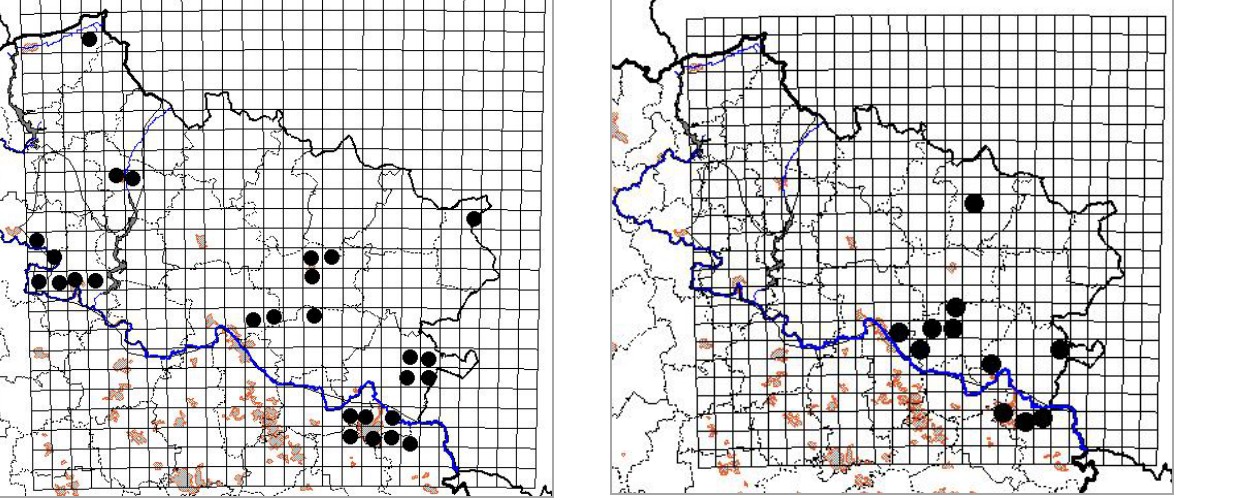
Fig. 18. The map of the distribution of Echinochloa crussgalli (L.) P. Beauv. in the Starobilsk grass-meadow steppe